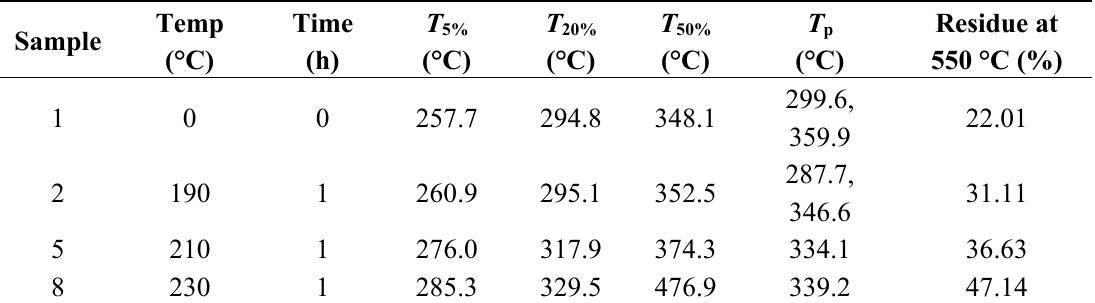
Table 2. Degradation temperature at 5, 20 and 50% fiber degradation, obtained by TGA of untreated and SHS-treated